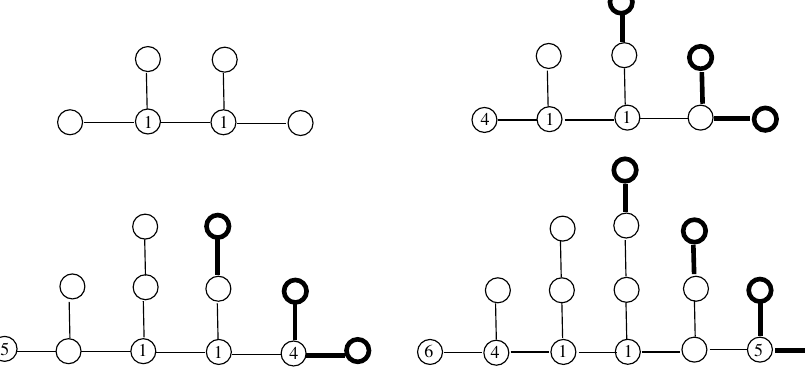
Figure 13: Antiregular dominating labelings of ˜ T